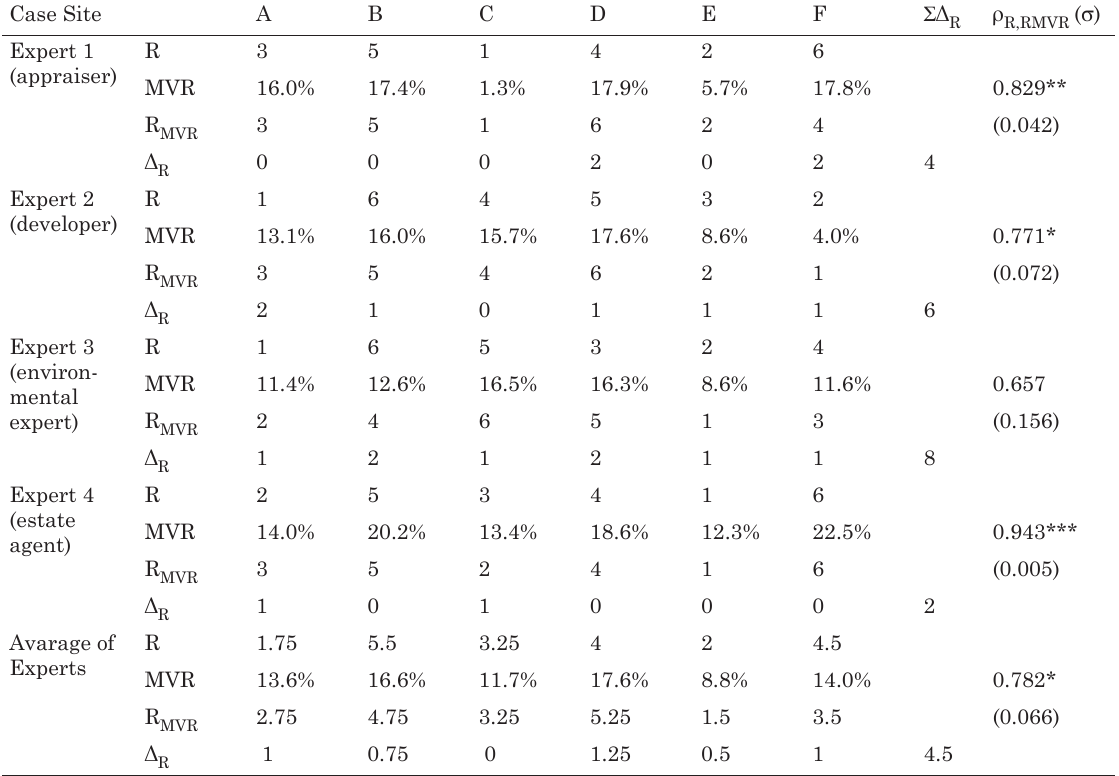
table 5. Thuringian case study ranking and mVr assessment by experts Case